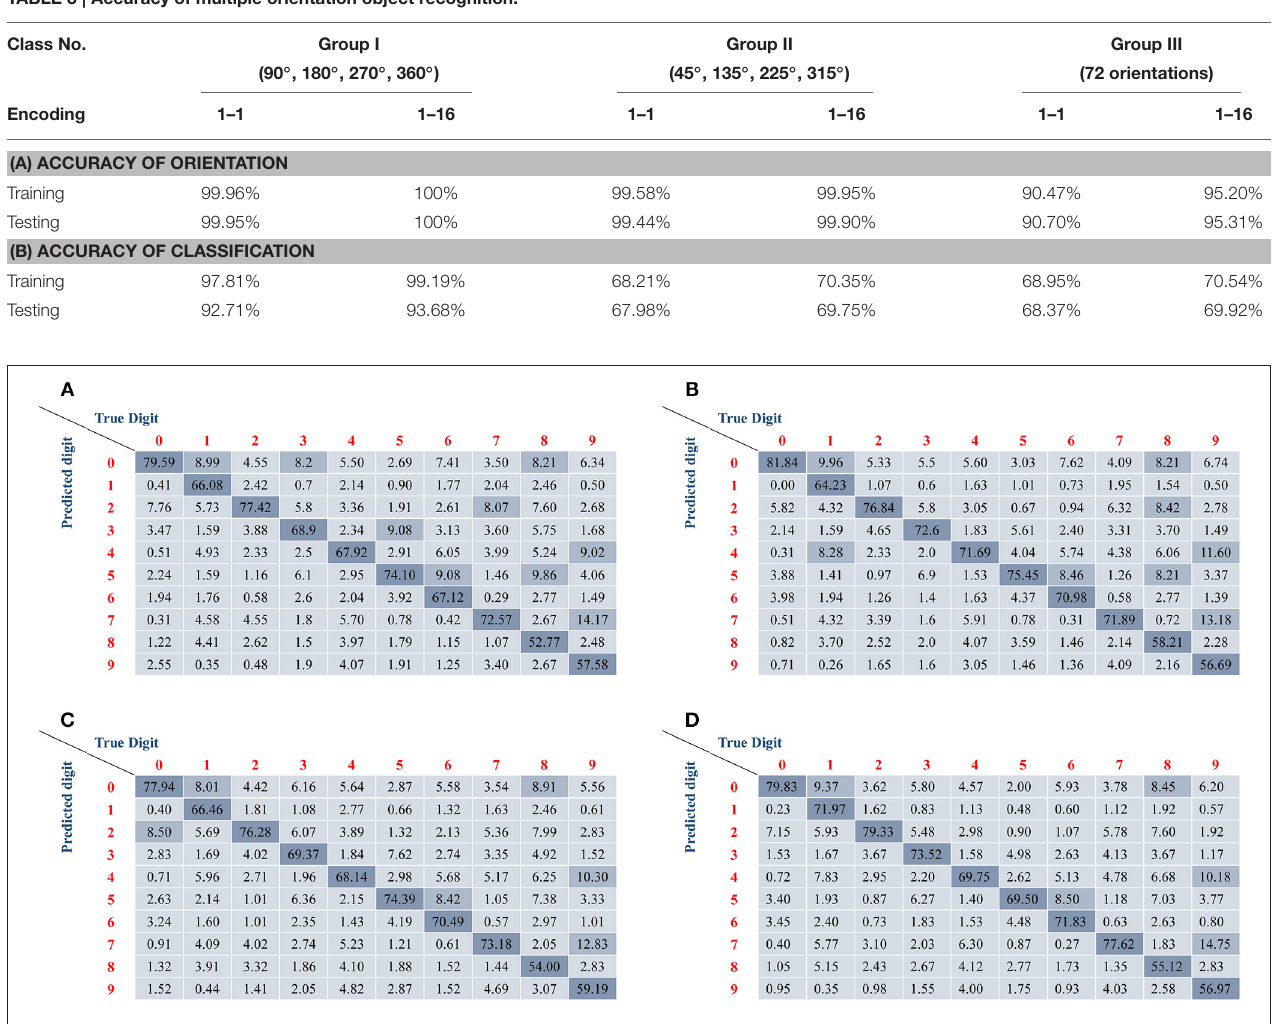
FIGURE 8 | The confusion matrices of different samples. The resulting confusion matrices from training samples with (A) one pixel one event encoding and (B) one pixel multiple events encoding. The resulting confusion matrix from testing samples with (C) one pixel one event encoding and (D) one pixel multiple events encoding. All results show higher accuracy for simple digits (such as 0, 1, 2, and 7) and lower accuracy for difficult digits (such as 8 and 9).